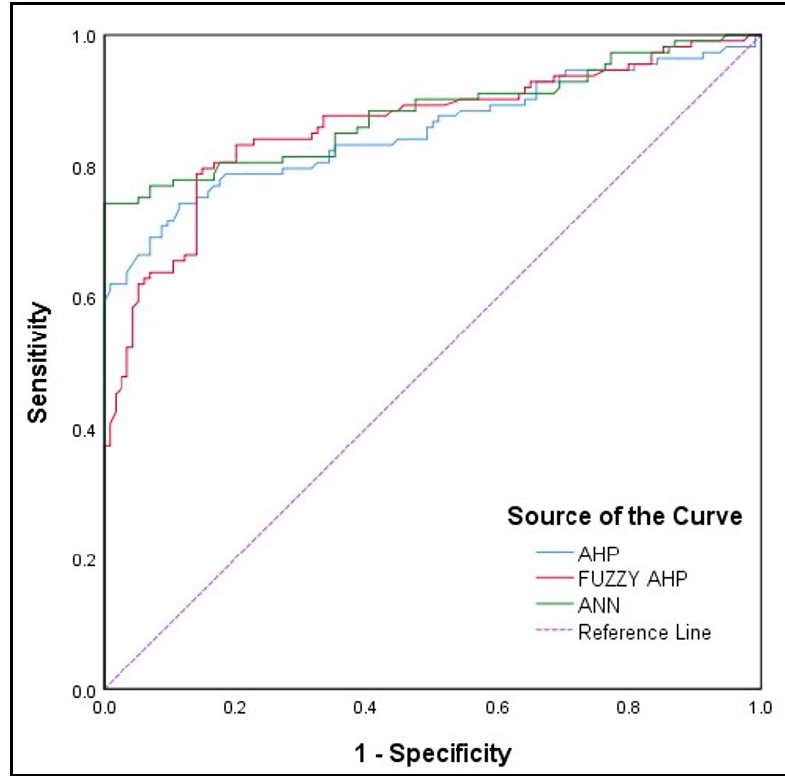
Figure 10. Overall accuracy curves for AHP, fuzzy-AHP, and ANN models.